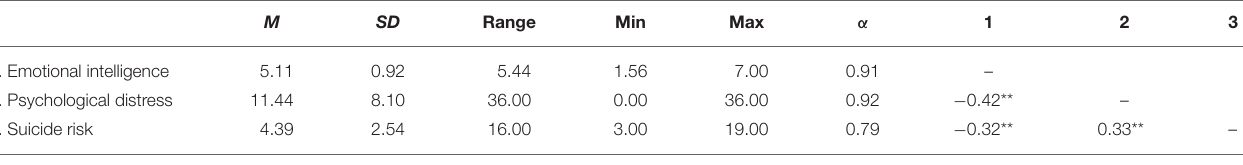
TABLE 1 | Descriptive statistics and bivariate correlations among the study variables in Study 1.